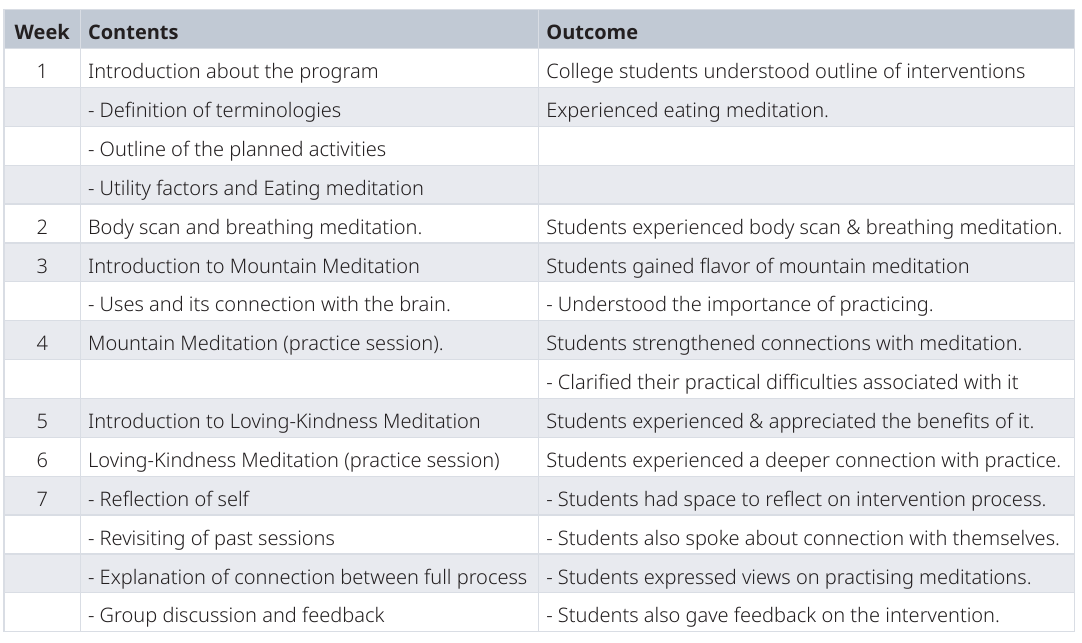
Table 1. Mindfulness-based interventions